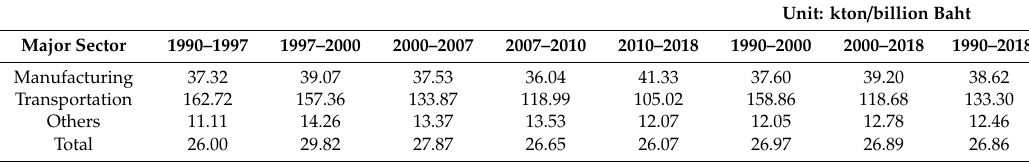
Table 8. CO 2 emission intensity of major economic sectors,